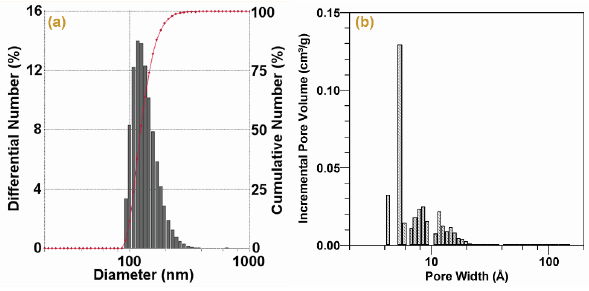
Figure 1. Particle ‐ size distribution ( a ) and DFT pore ‐ size distribution; ( b ) of PAC. Figure 1. Particle-size distribution ( a ) and DFT pore-size distribution; ( b ) of